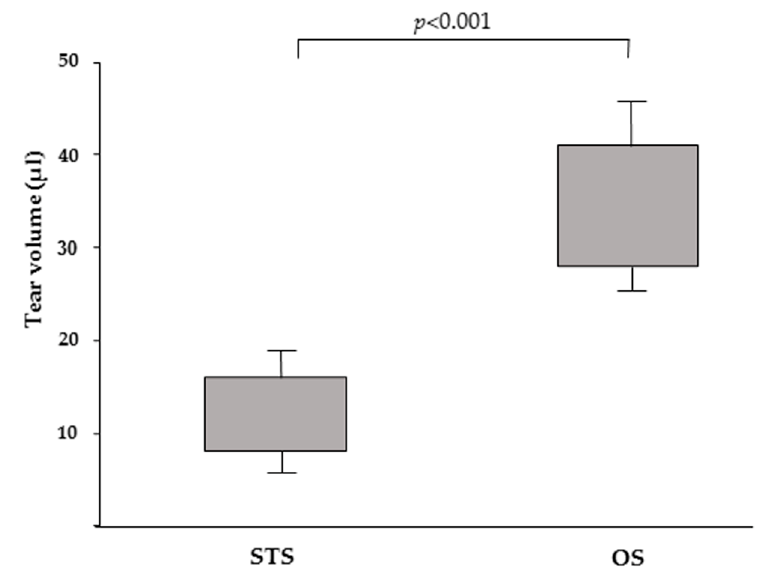
Figure 3. Box and whisker plots depicting the volume of tears collected by STS and OS.